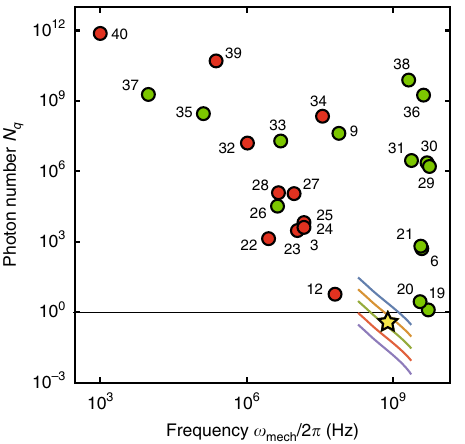
Fig. 4 Single-photon quantum regime. Each data point shows intra- resonator drive photon number N q necessary for the quantum-limited quadrature measurement of phonons as a function of mechanical eigenmode frequency ω mech ∕ 2 π . Green (red) circles indicate the values found in other opto-(electro-)mechanical systems with radiation pressure interaction. The yellow star shows the value obtained in this work. Color curves show the expectations from numerical simulations. Different colors correspond to the values of E J ∕ E C = {10 5 , 10 4 , 10 3 , 10 2 , 10} from top to bottom. A list of the references indicated by the numbers next to the circles is presented in the reference